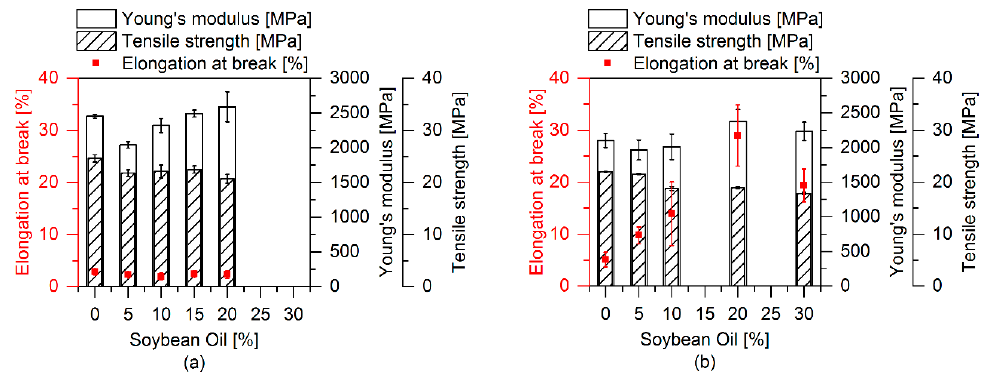
Figure 11. Tensile properties with varying contents of SBO inside the soft phase. Each sample contains 20 pph of soft phase. ( a ) Samples without EMAGMA and TBEC and ( b ) samples containing 5 pph EMAGMA and 0.2 pph TBEC.